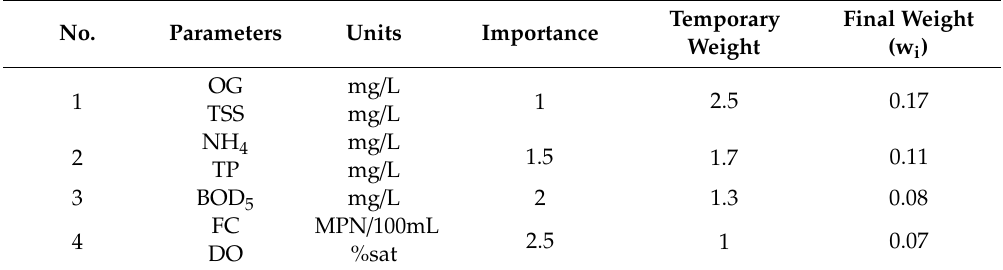
Table A4. The selected parameters for the WQI in the coastal zone and their weights [32].